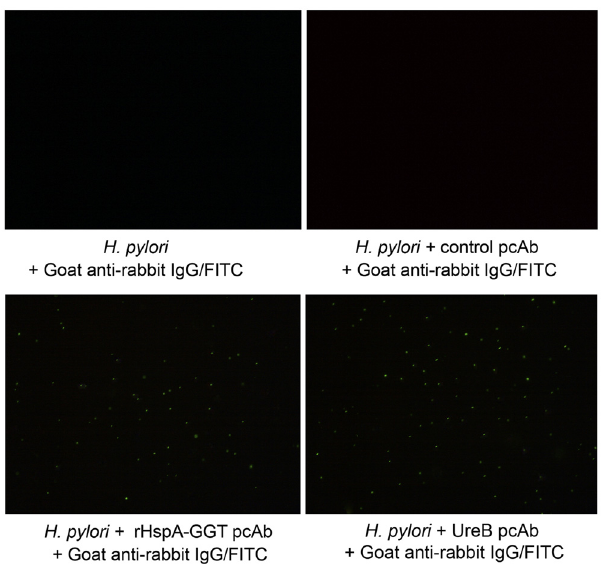
Fig 5. Indirect immunofluorescence confirmed that anti-serum collected from immunized mice directly binds H . pylori in vitro . No immunofluorescence was detected in the absence of antigen specific pcAb (A and B). Positive indirect immunofluorescence signals indicate binding of rHspA-GGT pcAb with H . pylori 26695 (C) and the existence of H . pylori (D). This study was performed twice, yielding similar results.